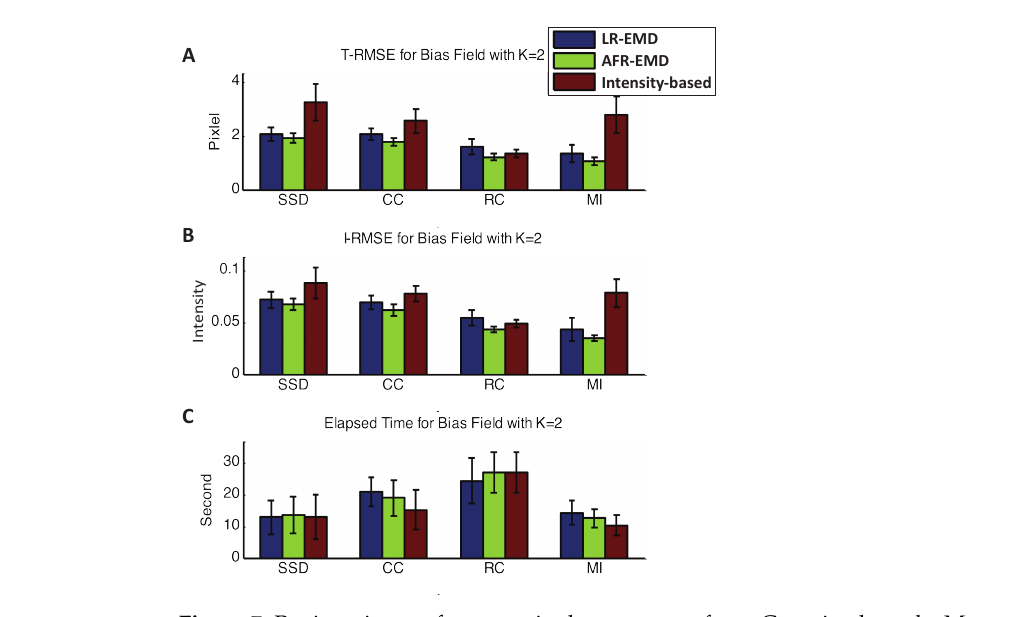
Figure 7. Registration performance in the presence of two Gaussian kernels. Mean and variance of T-RMSE and I-RMSE for images in BrainWeb dataset are shown in ( A , B ) panels. ( C ) panel compares the running time for all